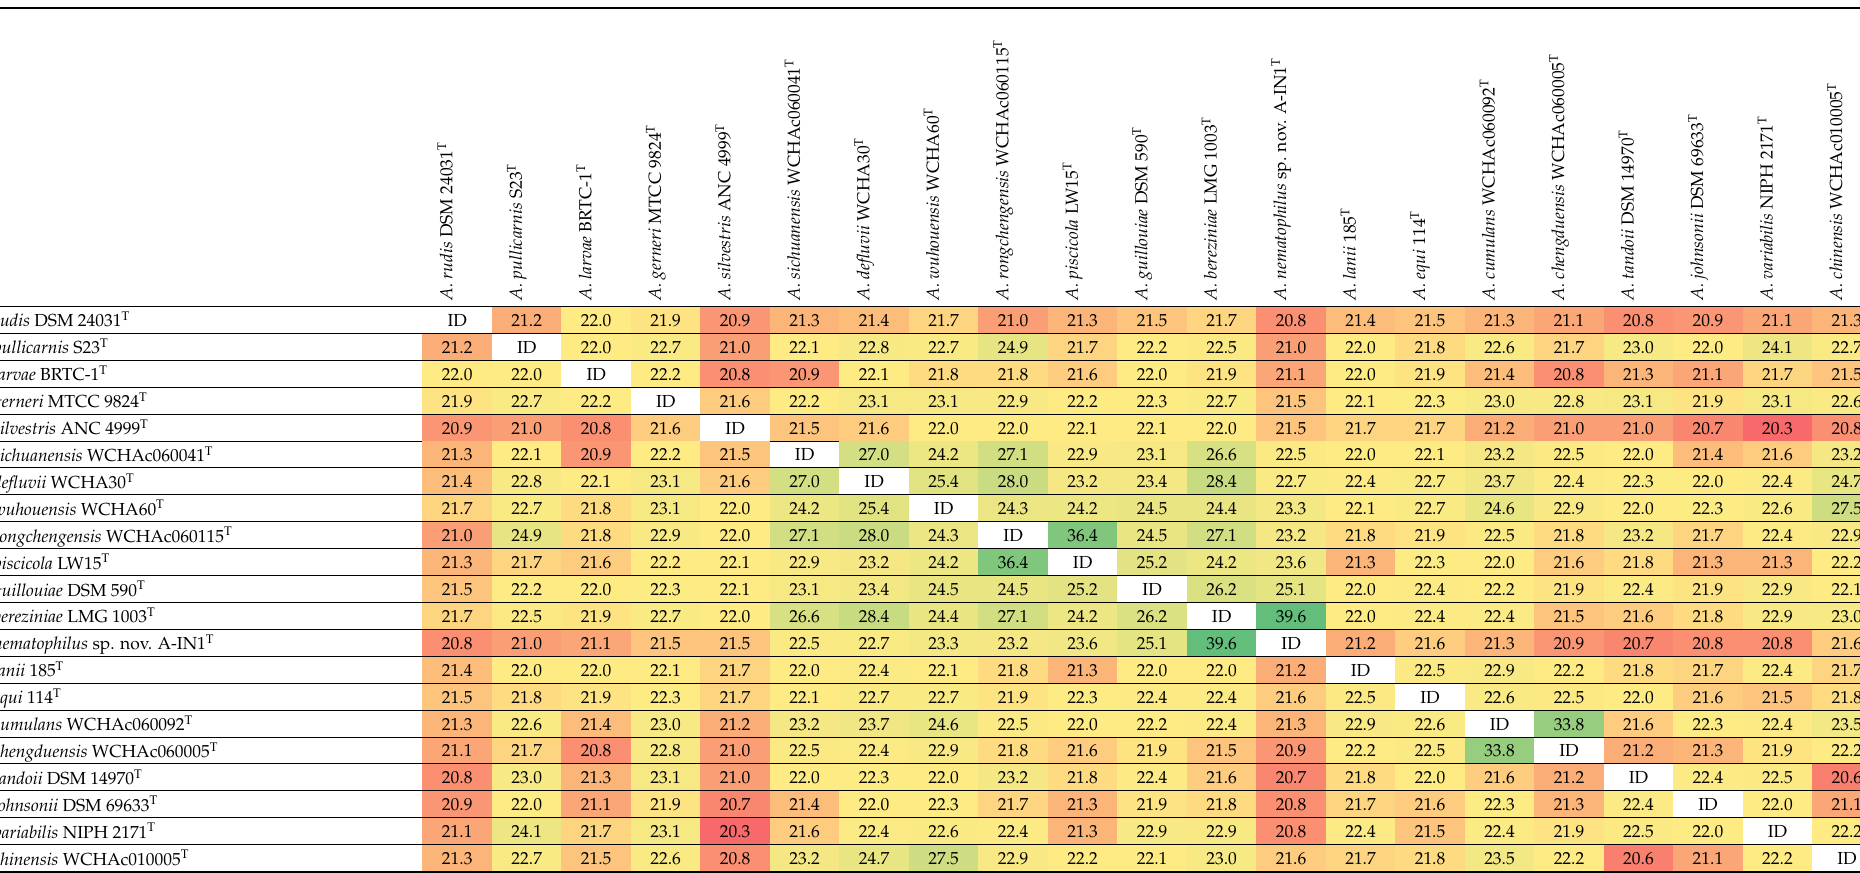
Table 1. Pairwise comparison of digital DNA-DNA Hybridization (dDDH) scores (%) of several species of the genus Acinetobacter . Accession numbers of the sequences used in the analyses are shown in Table S1. Colors indicate the degree of relatedness between bacterial species